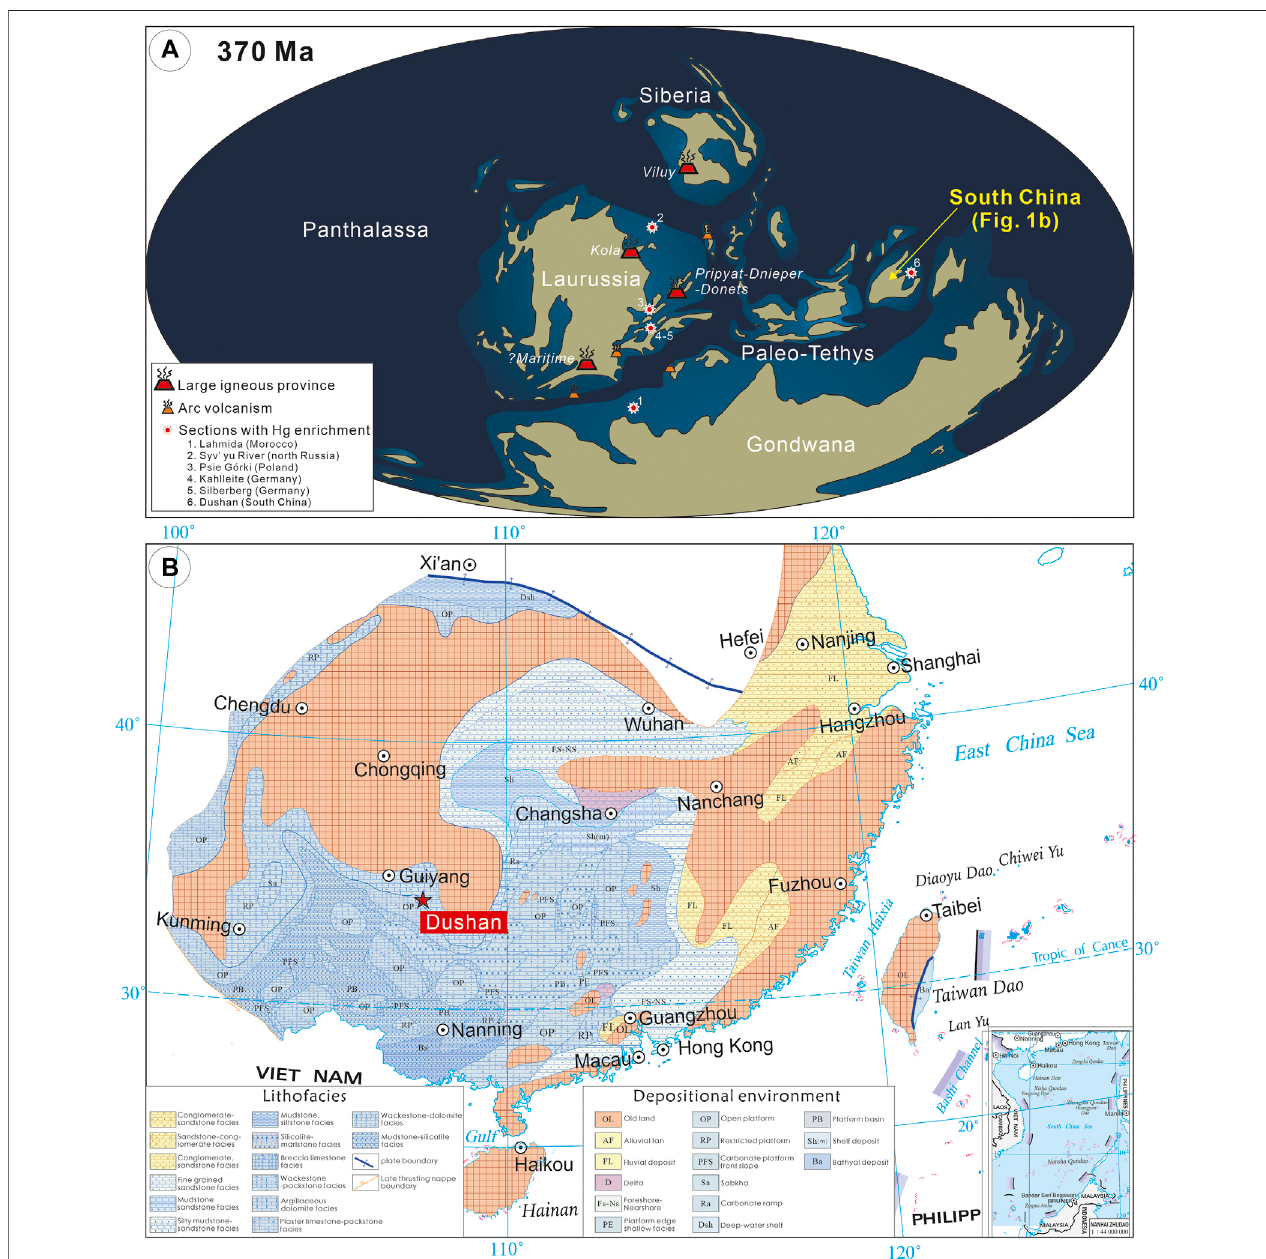
FIGURE 1 | (A) Paleogeographic reconstruction of the Late Devonian (370 Ma). The base map is from Blakey (2016), and assumed locations of coeval igneous activitiesandHgenrichmentsectionsarefromRacki(2020). (B) PaleogeographyofSouthChinaduringtheLateDevonianandlocationoftheDushanarea(modi fi edafter Zhao,